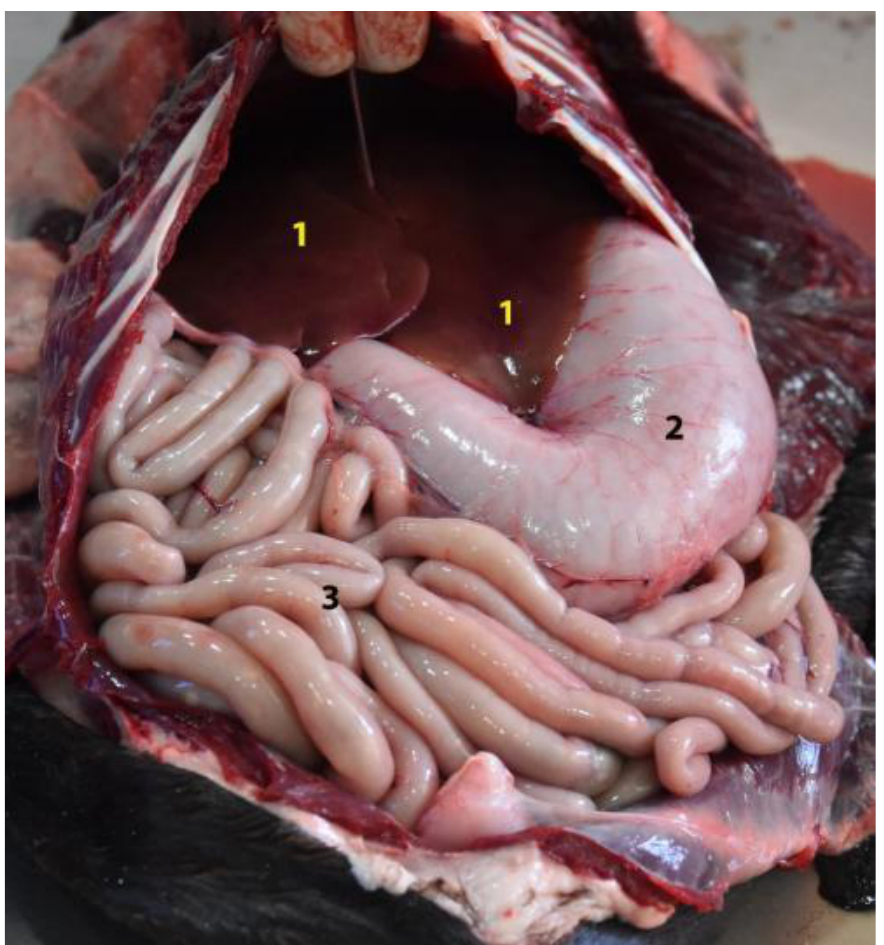
Figure 23. General view of the abdominal cavity (body in dorsal recumbency). Note the liver in situ. ( 1 ) Parietal surface of the liver; ( 2 ) stomach; ( 3 ) small intestine.